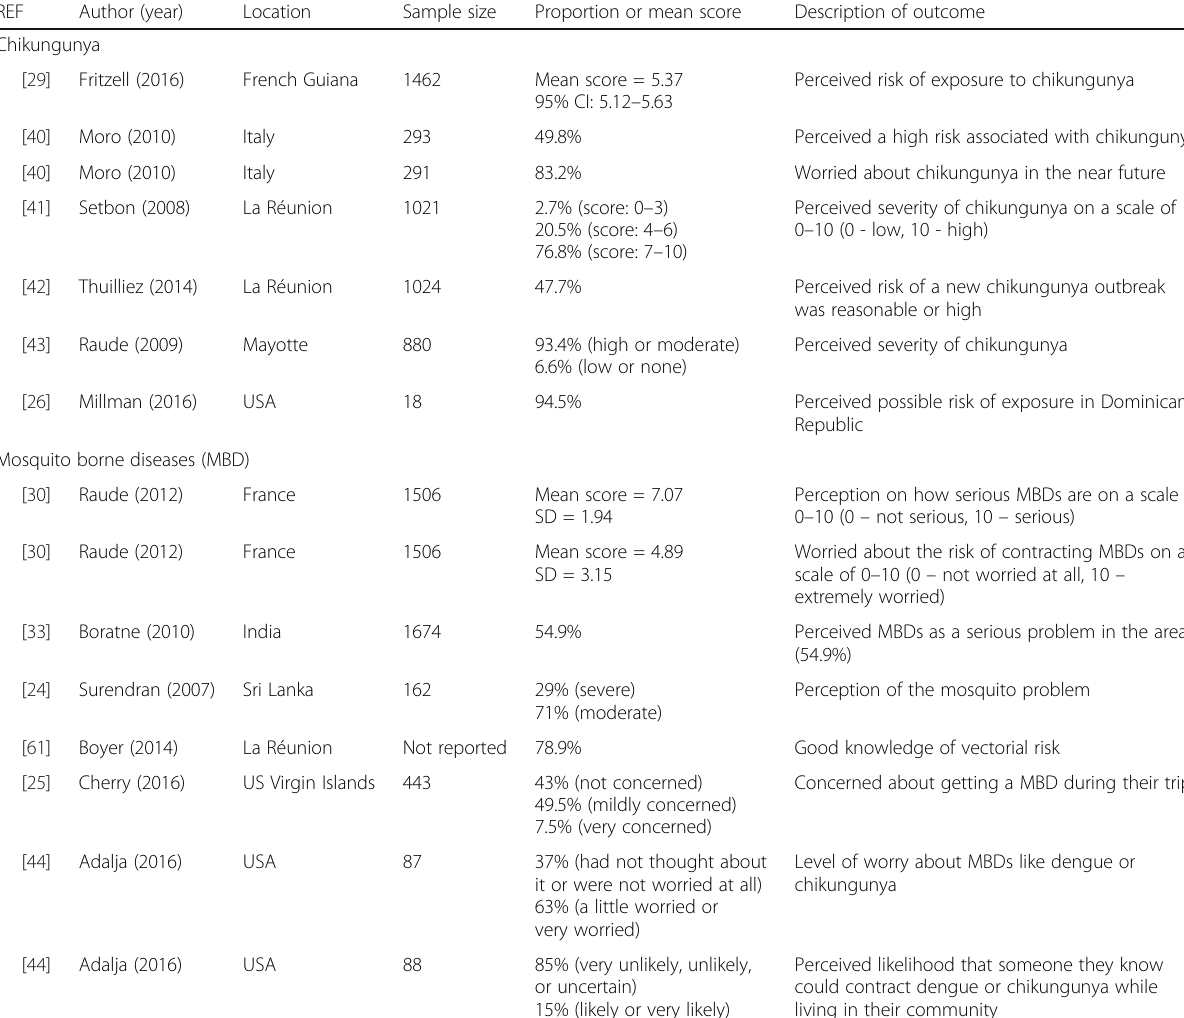
Table 2 Perceived risk and severity of chikungunya and mosquito borne diseases (MBDs) among the general public